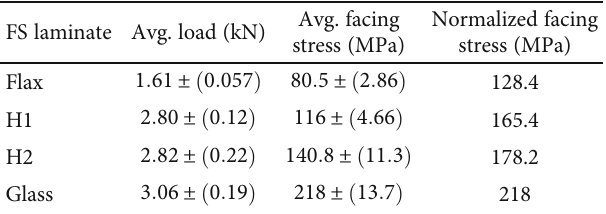
Figure 10: Load-extension curves of the fl exural test. Table 5: Flexural load and facing stress of the composite sandwich